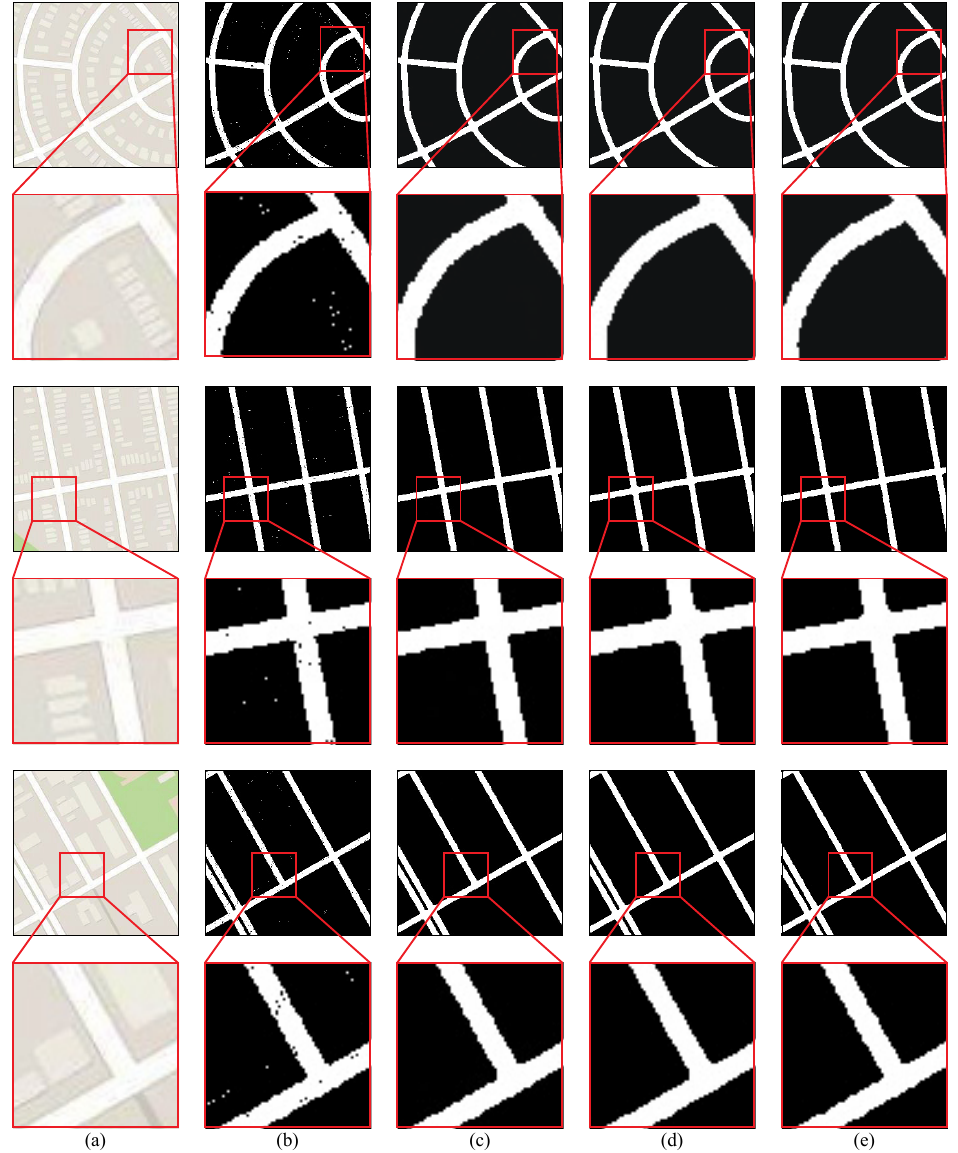
Figure 10. Comparison of several removal results: ( a ) mapping images, ( b ) binary images, ( c ) DE results, ( d ) median filtering results, and ( e ) Gaussian filtering results.